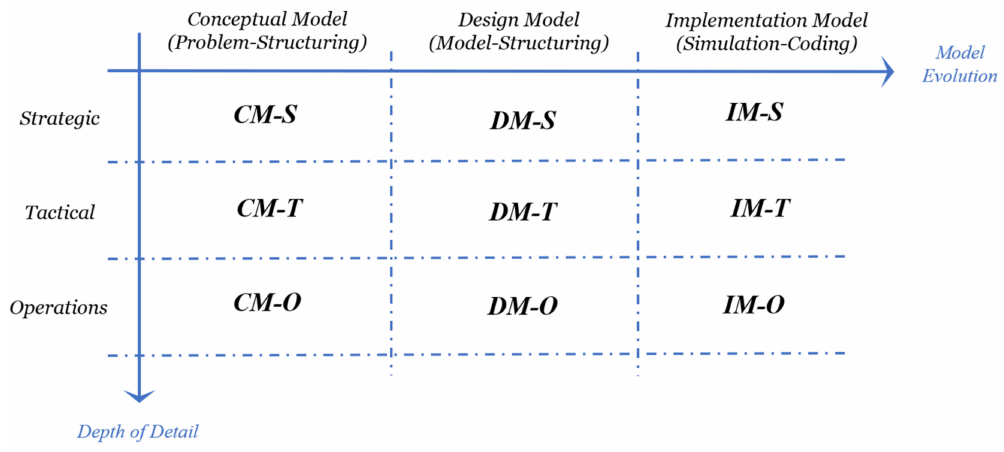
Figure 6. Naming of models according to their position in the modelling